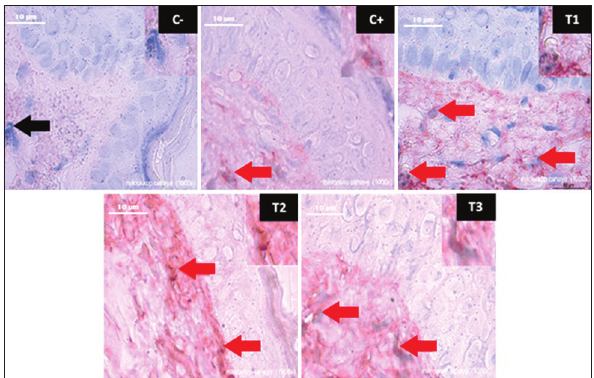
Figure-2: Cytotoxic T lymphocyte (CTL) expression in the treatments of C−, C+, T1, T2, and T3. ( → ) The black arrow shows the normal T lymphocyte, ( → ) the red arrow shows CTL expression on skin epithelial